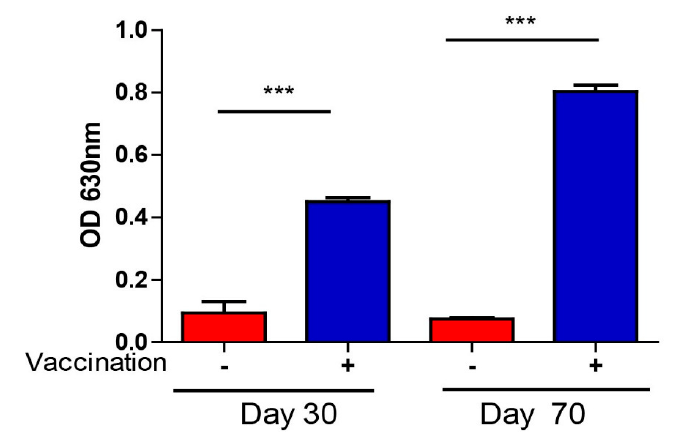
Figure 4. Relative levels of Toxoplasma- specific IgG, as determined by indirect ELISA. Sera from naïve mice were used as controls, and three mice from each group were analyzed. *** p < 0.001, NS: not significant, Student’s t -test.